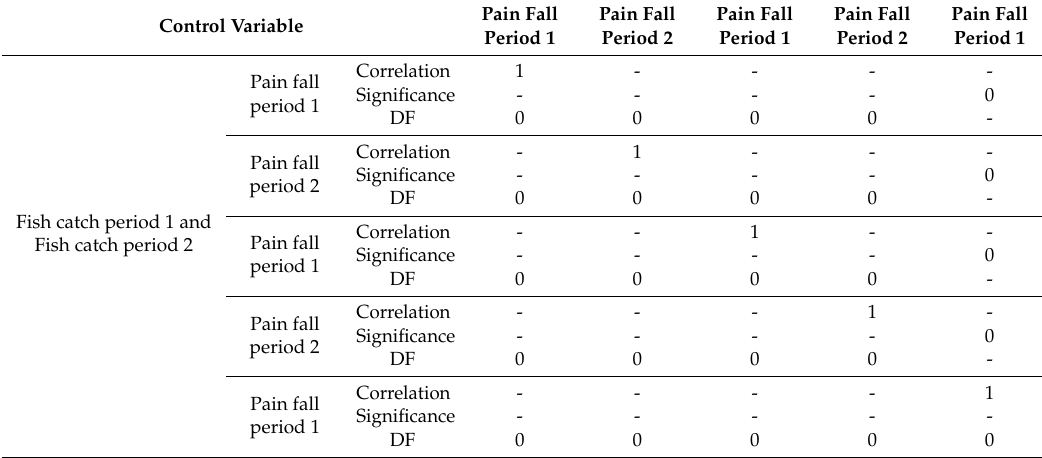
Table 3. Correlation between the aquatic ecosystem and the